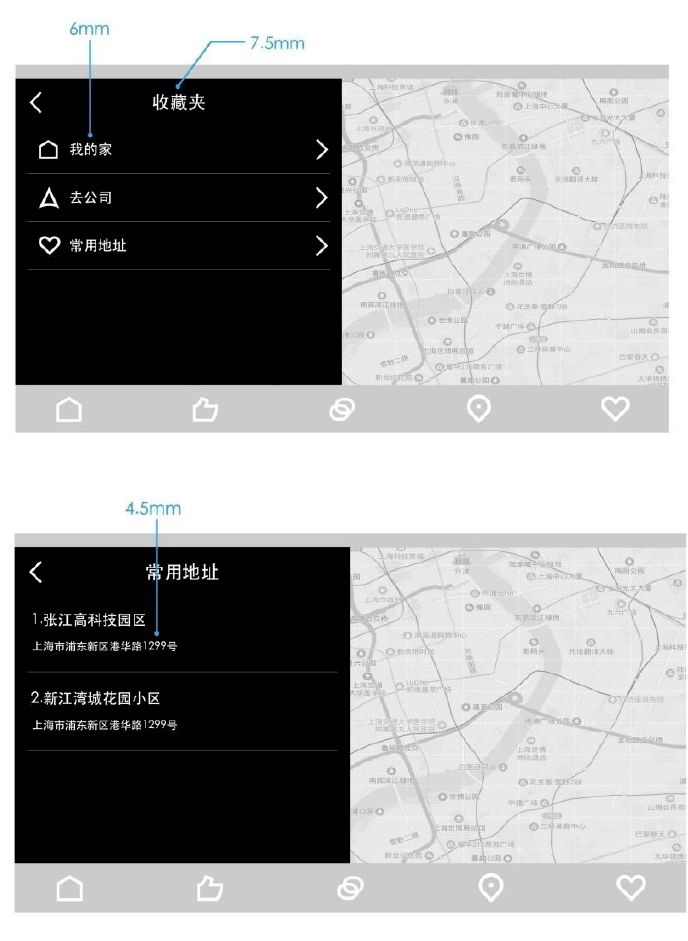
Figure 9. Examples of Chinese character interface design.